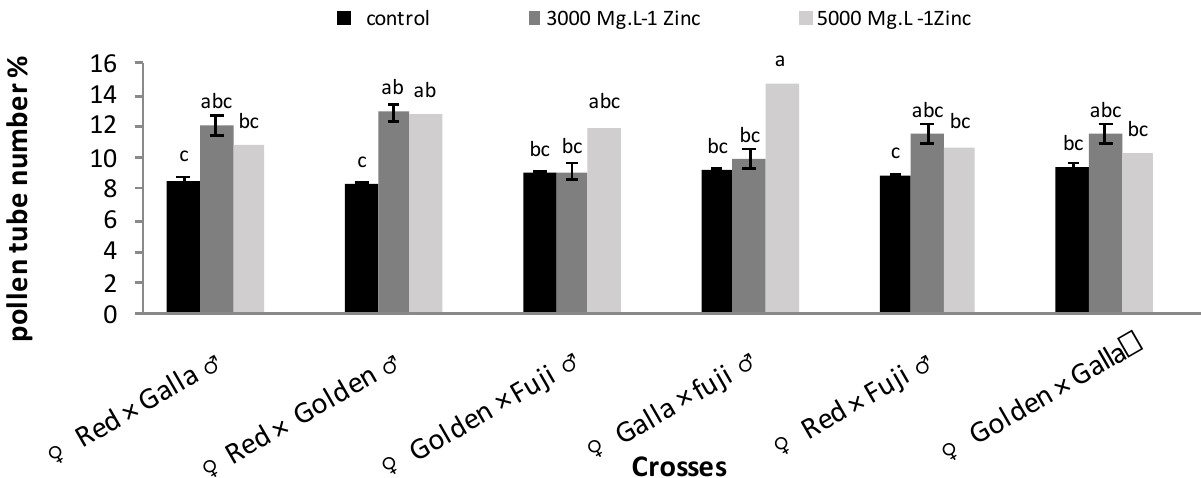
Fig. 5. The interactions between Zn concentration and crosses on the pollen tube penetration into the beginning of the ovary in different crosses. Means in each column, followed by similar letter (s) are not significantly different at 1% probability